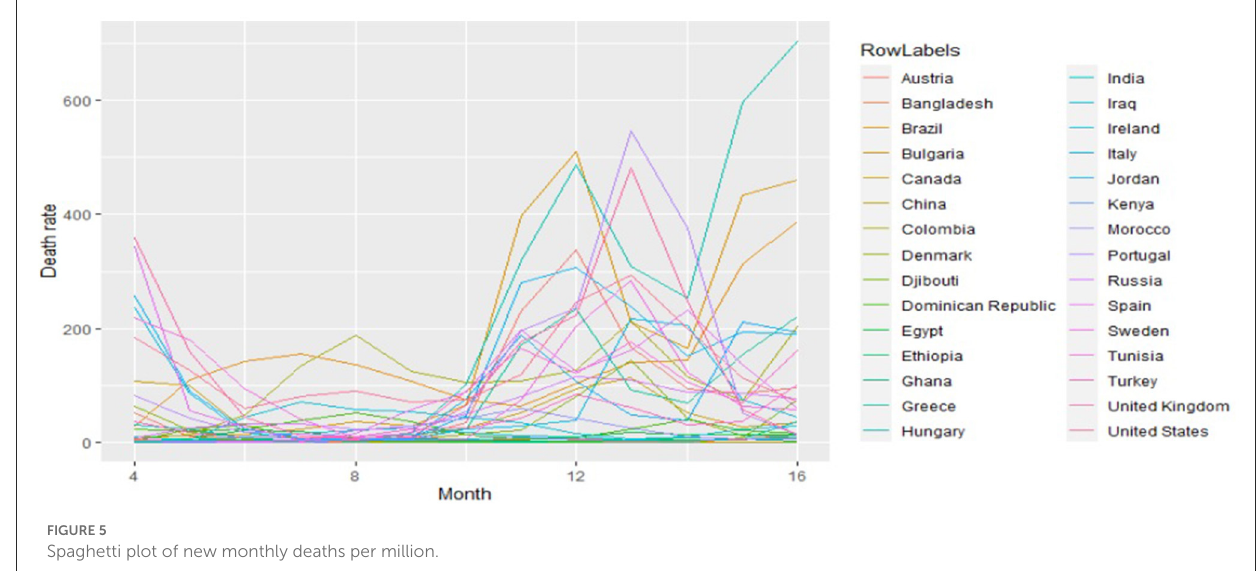
FIGURE5 Spaghetti plot of new monthly deaths per million.